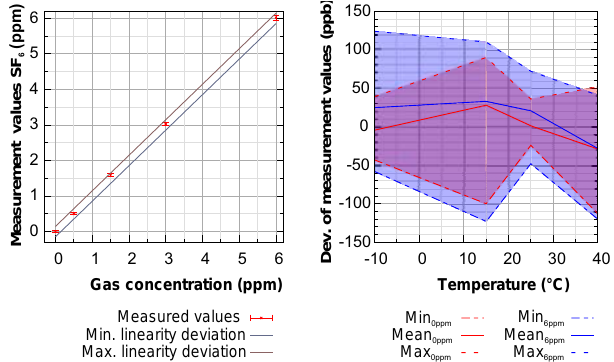
Measured values Min. linearity deviation Max. linearity deviation Figure 3. Designated representation of nonlinearity in the sub-ppm range over a temperature range of − 10–40 ◦